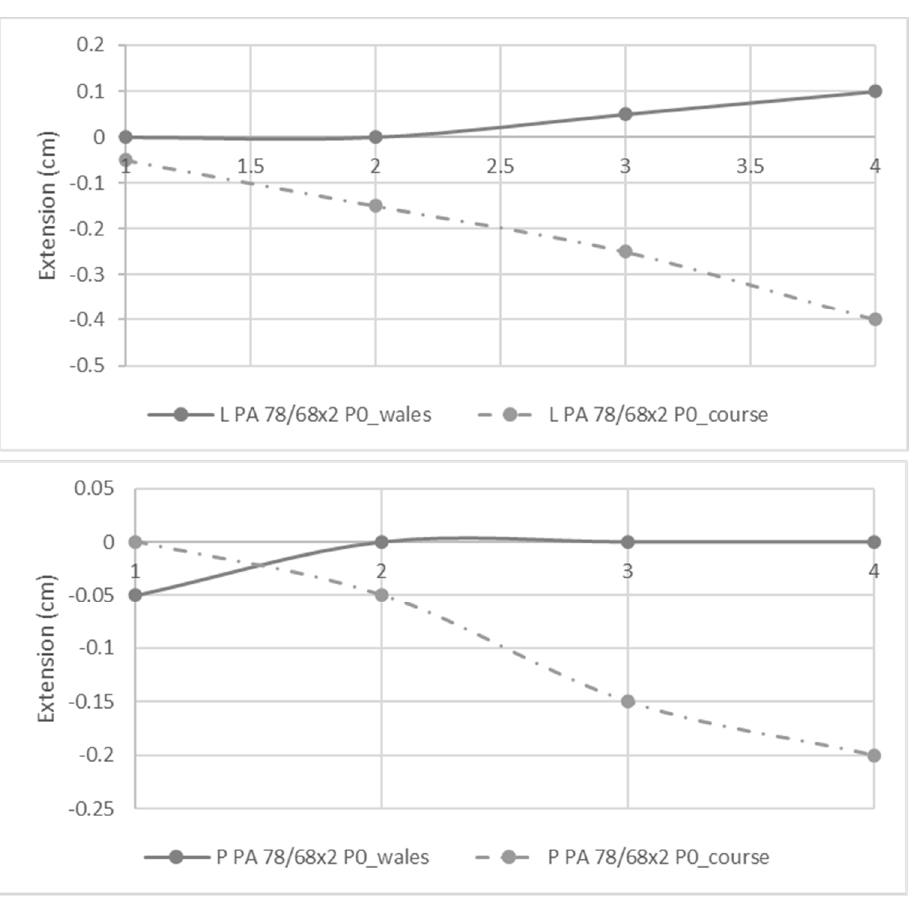
Figure 2. Extension of knits with L and P patterns in wales and course direction when imposed extension in the opposite direction. The x -axis represents the strain being applied.